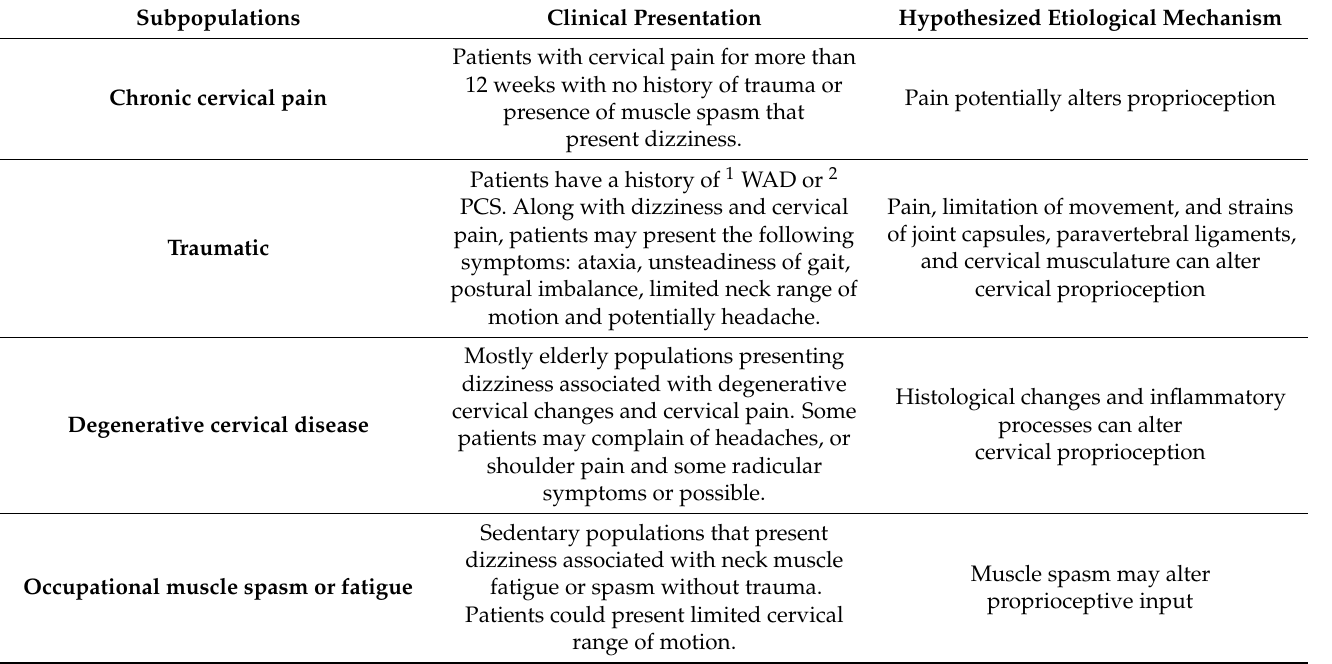
Table 1. Subpopulations, clinical presentation and hypothesized etiological mechanism.